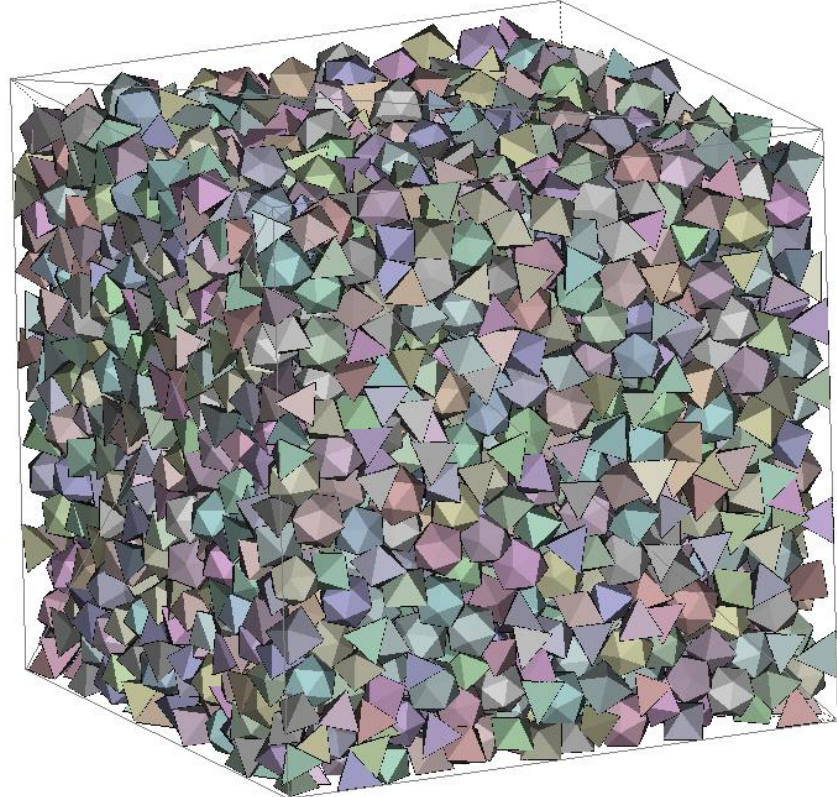
Figure 6. Arrangement of particles for Fraction 2.